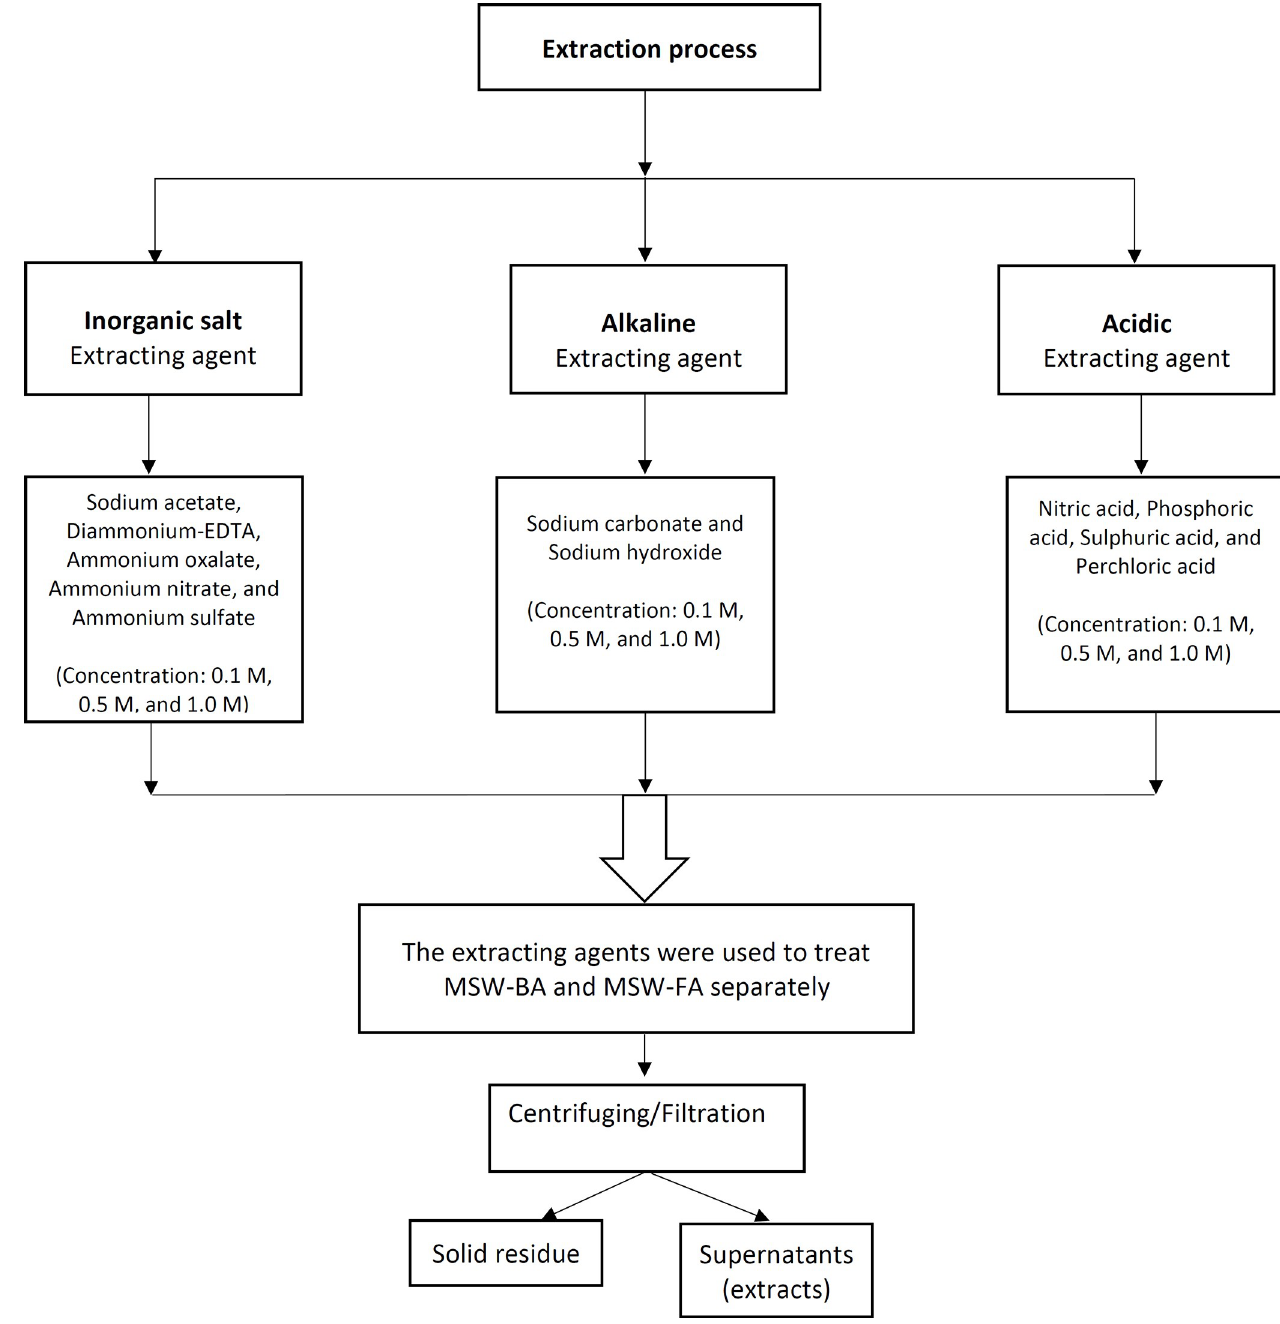
Fig 1. Scheme 1. Suggested extraction procedures adopted in this current